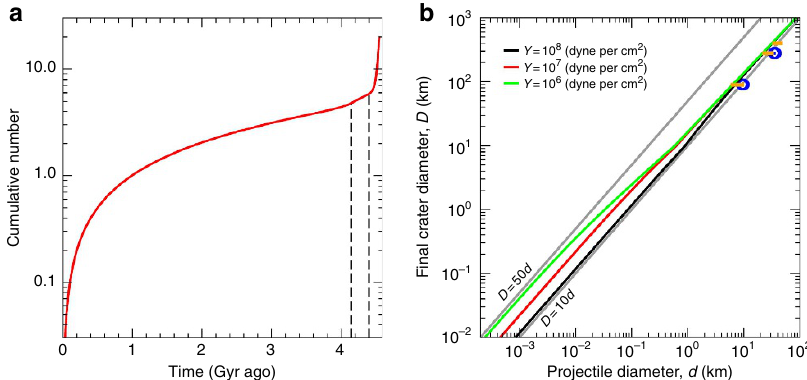
Figure 5 | Model impact flux and crater scaling laws. ( a ) Cumulative number of impacts (normalized to 1 at 1Gyr ago). Dashed lines indicate the approximate on-set of the late heavy bombardment (4.15Gyr ago), and the end of the primordial depletion (4.4Gyr ago), as described in the text. The shape of the impact flux curve is valid regardless of the impactor size, although it needs to be properly rescaled by the number of main belt asteroids larger than a given size to compute the actual number of collisions. ( b ) Solid curves correspond to the general crater scaling law of ref. 23 (their Table 1), corrected for the transient-to-final crater size (using a factor of 1.3 as discussed at http://keith.aa.washington.edu/craterdata/scaling/usermanual.html; complex crater sizes are further corrected using ref. 41). Other scaling law parameters are n ¼ 0.4, m ¼ 0.55, K 1 ¼ 0.93. Different colours (red, green and black) correspond to indicated values of target strength. Note that for D 4 B 20km, the effect of target strength becomes negligible, thus the actual value of strength does not affect our conclusions. As a reference, oblique grey lines indicate a constant scaling of D ¼ 10 (cid:3) d and D ¼ 50 (cid:3) d . Horizontal segments (orange) indicate results from the scaling laws summarized in ref. 24. They were computed using three crater diameter values as reference (92km Occator; 280km Kerwan and 400km). The left-most extreme of each line corresponds to ref. 24 hard rock scaling, while the right-most value corresponds to porous scaling. Finally, we report the results of iSALE simulations 25 of Ceres cratering calibrated to reproduce Occator and Kerwan crater’s sizes (blues circles).